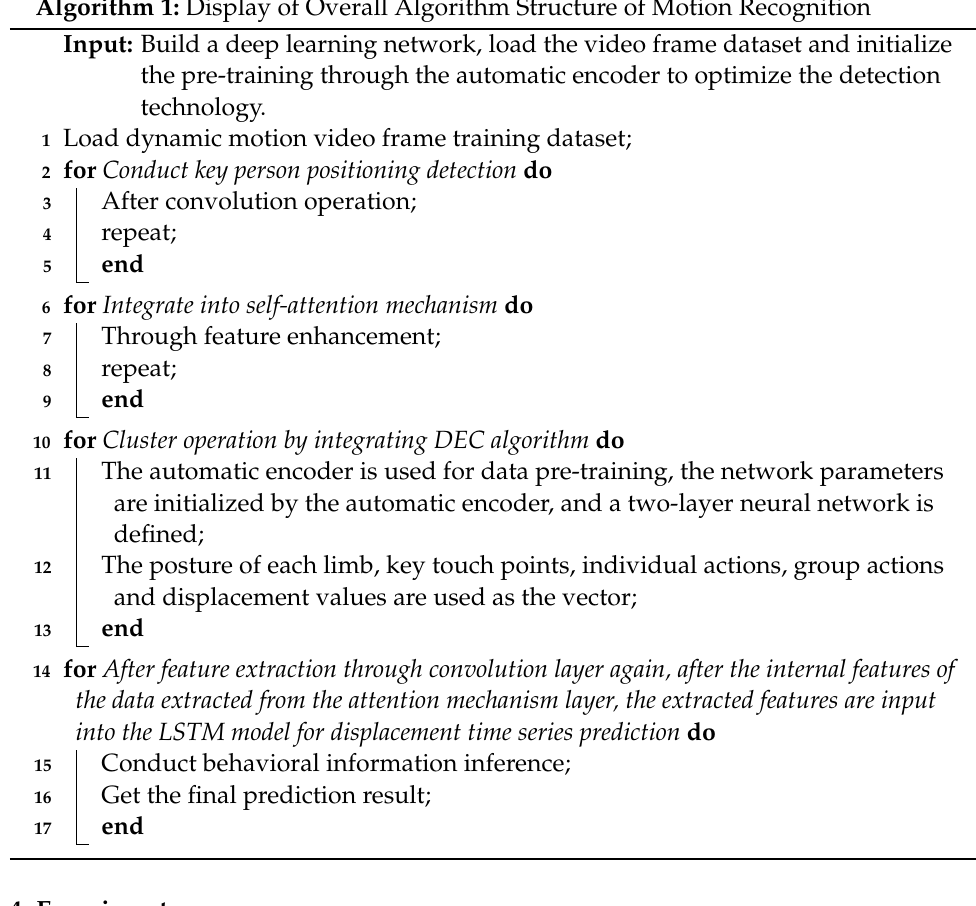
Algorithm 1: Display of Overall Algorithm Structure of Motion